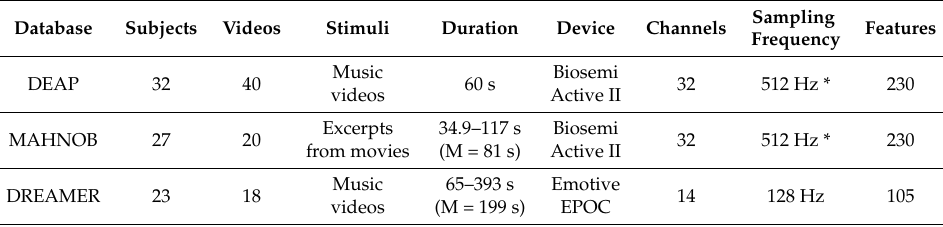
Table 1. Summary of characteristics for the databases in the